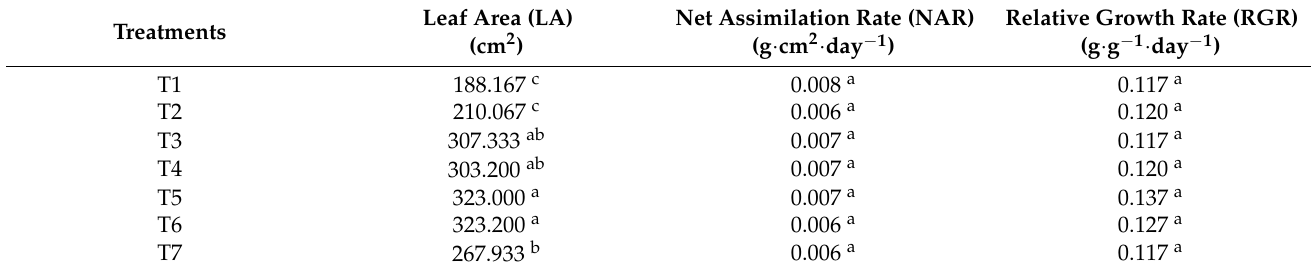
Table 2. Effect of chemical, organic, and biofertilizer treatments on some vegetative growth traits of cucumber plants grown under greenhouse